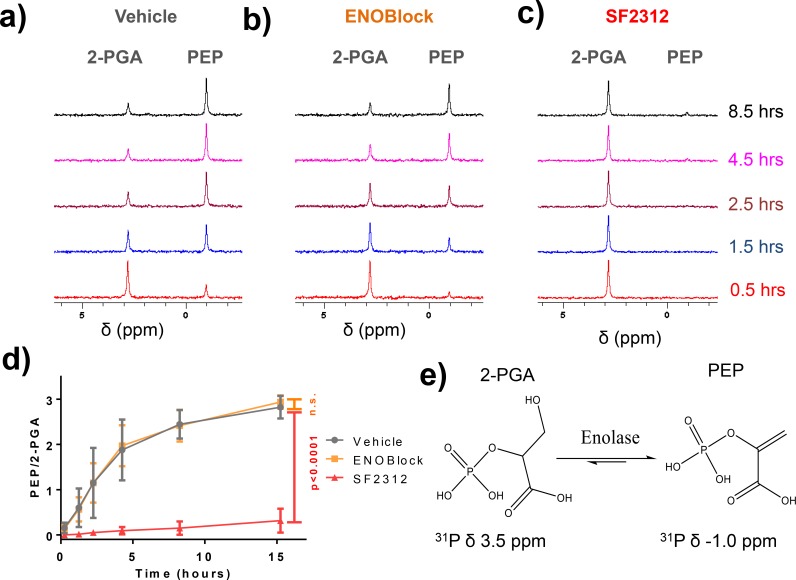
ENOblock does not inhibit the conversion of 2-PGA to PEP as measured by 31P NMR Experimental conditions were the same as for the experiments presented in Fig 2, except that 10% D2O was added for signal lock and the experiment was performed at room temperature.31P NMR scanning was performed with 1300 transients, totaling 1 hour of measurement with the first time point being taken as half the time of measurement (0.5hr). (a) The 2-PGA peak (3.5 ppm, e) was stable for >24hrs in the absence of enzyme, but rapidly decreased with a concomitant increase in the PEP peak (-1ppm, e) in the presence of 10 nM recombinant hENO2. (b) Pre-incubation with 500 μM ENOblock did not slow the conversion of 2-PGA to PEP, but 20 μM SF2312 eliminated it Panel (c). (d)The ratio of integrals of 2-PGA and PEP as a function of time are shown for vehicle (grey), 500 μM ENOblock (orange), and 20 μM SF2312 (red). Each data point represents mean of N = 4 ± S.D. Differences between vehicle and ENOblock was not significant (n.s. = not significant; p = 0.69); while that between vehicle and SF2312 was highly significant (p<0.0001; Generalized linear regression model). Panel (e) shows the structure of 2-PGA and PEP with the published chemical shifts in the 31P spectrum.